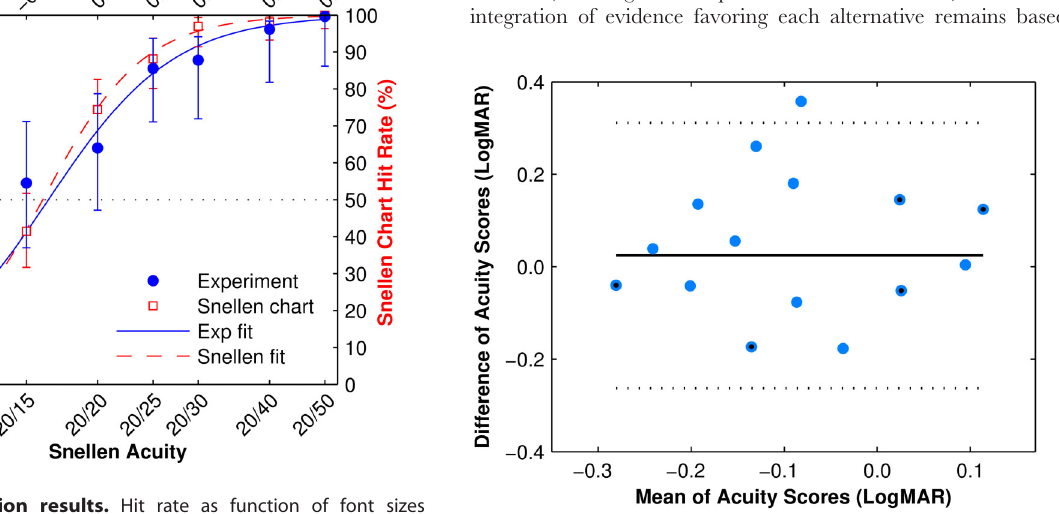
Figure 8. Validation results. Hit rate as function of font sizes (translated to the equivalent acuity) for the standard Snellen chart test (red unfilled squares) and the multiple-optotype two alternative forced choice (MO2AFC) letter recognition task (blue filled circles). Error bars are two-sigma confidence levels. Smooth traces are sigmoid fits to each data set. Uneven spacing across the horizontal axis reflects the step sizes between lines in the standard Snellen chart. Results from the letter recognition task have been normalized to span [0–1], an equivalent range as the Snellen chart test (0%–100%), for ease of comparison. The two curves are in high agreement, although there appears to be a trend to a shallower transition with the letter recognition task, possibly due to uncorrected false negatives at the upper end of the range.